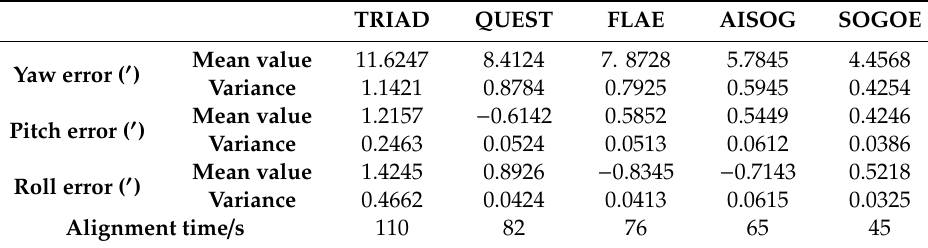
Figure 4. The attitude angle errors of the three alignment methods. Table 2. Comparison of the attitude angle error and alignment time.